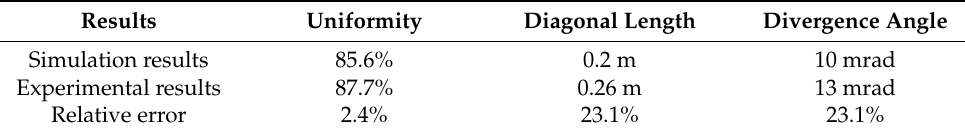
Table 3. Experiment results compared with simulation results (20 m).